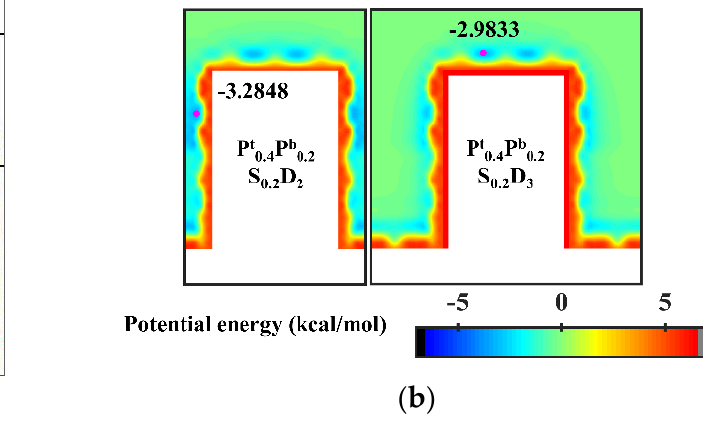
Figure 13. ( a ) The snapshot of the condensate formed on the surfaces at the end of the simulation in the cases of P t 0.4 P b 0.2 S 0.2 D 2 and P t 0.4 P b 0.2 S 0.2 D 3 . ( b ) Equipotential curves of potential energy between water molecule and the nanopillar surfaces (P t 0.4 P b 0.2 S 0.2 D 2 and P t 0.4 P b 0.2 S 0.2 D 3 ). The minimum values of the potential energy are given in the figure and their positions are marked with a pink dot.